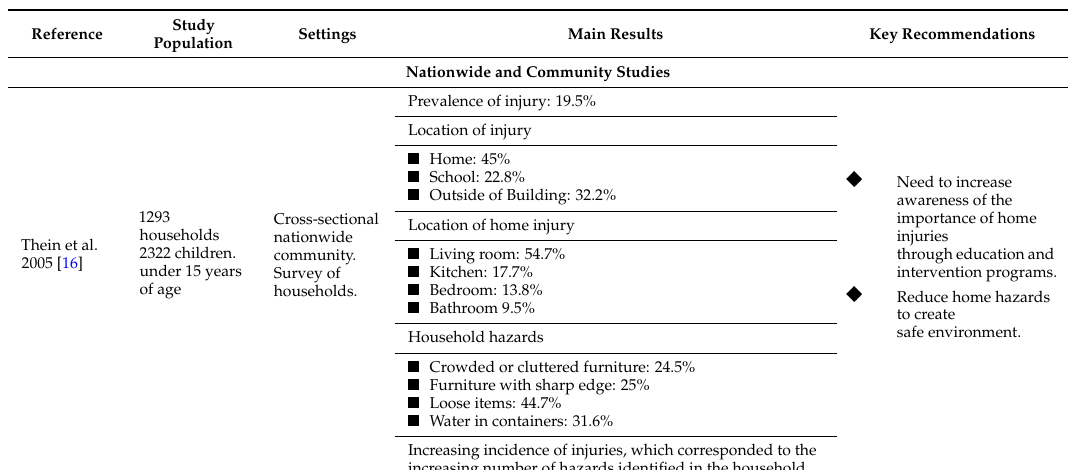
Table 1. Summary of Main Papers on Childhood Injuries in Singapore.